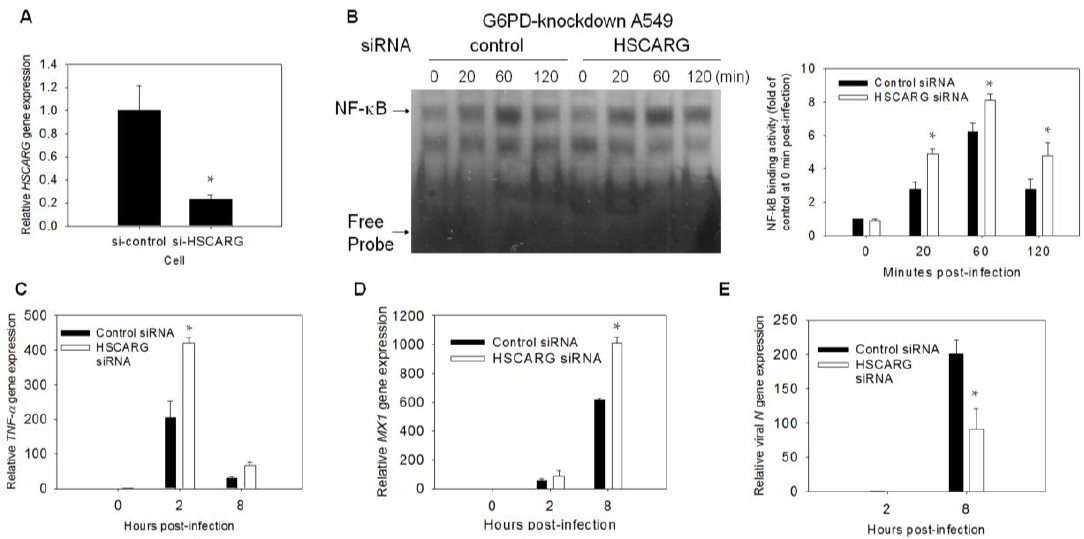
Figure 6. HSCARG -knockdown increases antiviral response and decreases viral replication. ( A , B ) A549-Gi cells were transfected with HSCARG siRNA. Total RNA was collected at 48 h after transfection, and HSCARG gene expression was determined by quantitative-PCR. Level of HSCARG was expressed relative to that of A549-Gi cells transfected with control-siRNA. For assay of NF-êB binding activity, A549-Gi cells were transfected with control or HSCARG siRNA for 48 h, and subsequently infected with HCoV 229E at MOI of 0.1. At indicated time points p.i., NF-êB binding activity was analyzed by EMSA. The temporal change in NF-êB binding activity is shown and quantified by densitometric scanning. The values represent average ± SD of five independent experiments; ( C – E ) A549-Gi cells were transfected with control or HSCARG siRNA for 48 h, and subsequently infected with HCoV 229E at an MOI of 0.1. Total RNA was harvested at indicated time points p.i., and analyzed for expression level of TNF- α ( C ), MX1 ( D ), and viral N genes ( E ) by quantitative-PCR. Values represent average ± SD of three experiments. * p < 0.05 as compared to control siRNA treated cells.